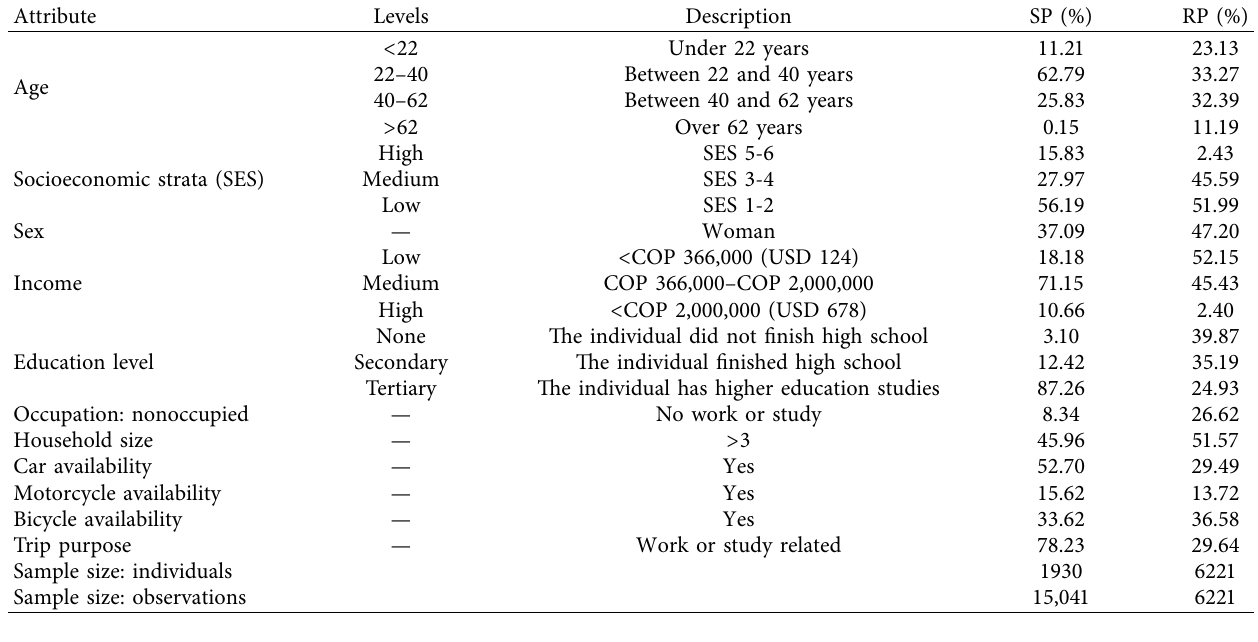
Table 3: Summary of main attributes of the individuals included in each dataset.